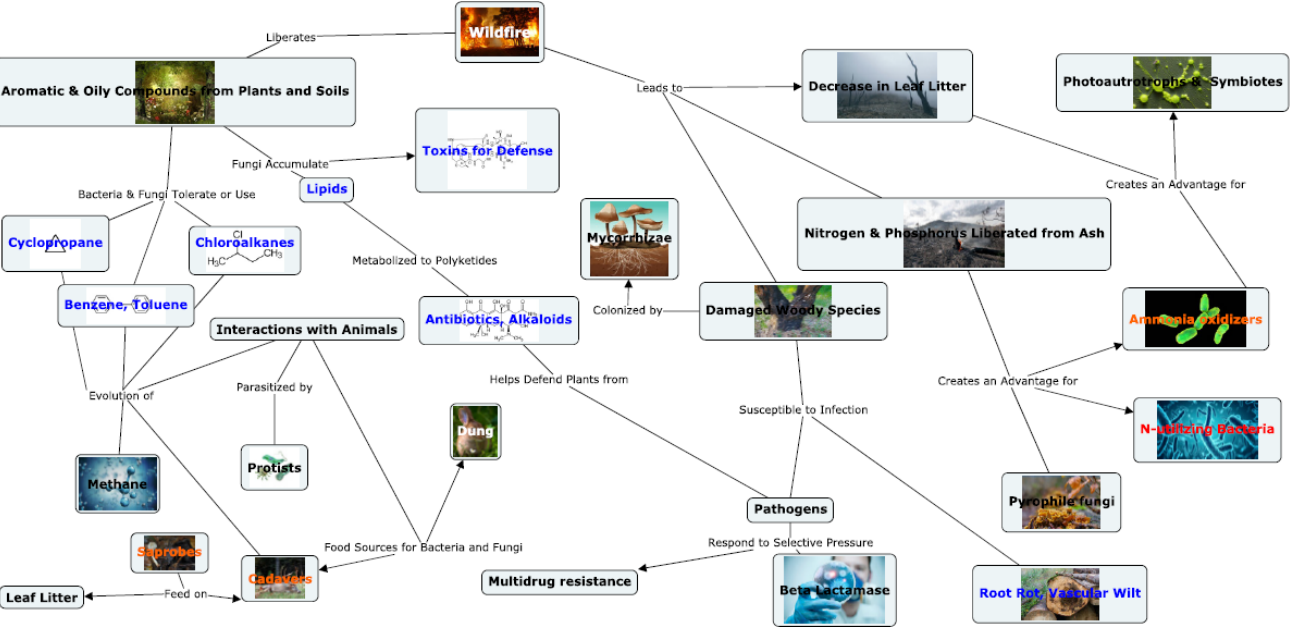
Figure 9. A proposed Soil Food Web of the Gold Creek Preserve, showing the most important redundant functions and known species interactions.